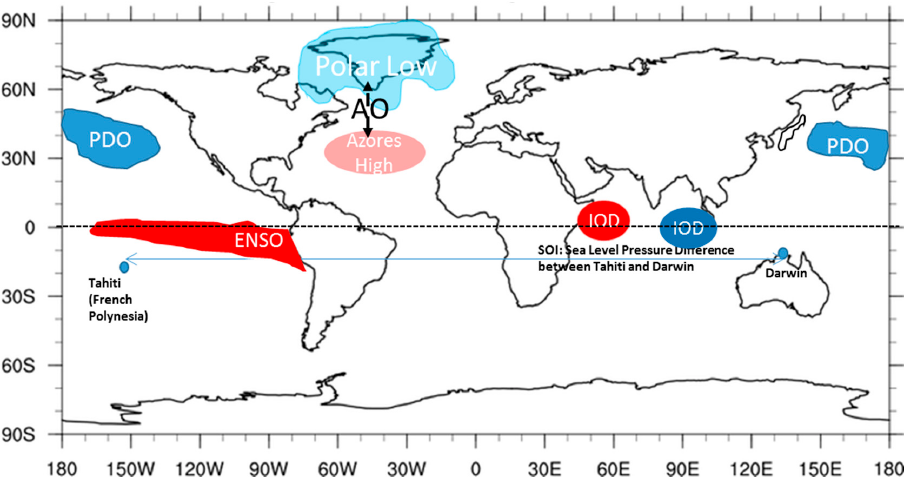
Figure 1. Location of the most common climate indices (positive part of a signal). Red color shows positive anomalies, while blue shows negative anomalies. Arctic Oscillations (AO), El-Nino Southern Oscillations (ENSO), and Pacific Decadal Oscillations (PDO) are the differences between the surface sea level pressure over the selected location. Indian Ocean Dipole (IOD) is a sea surface temperature difference.